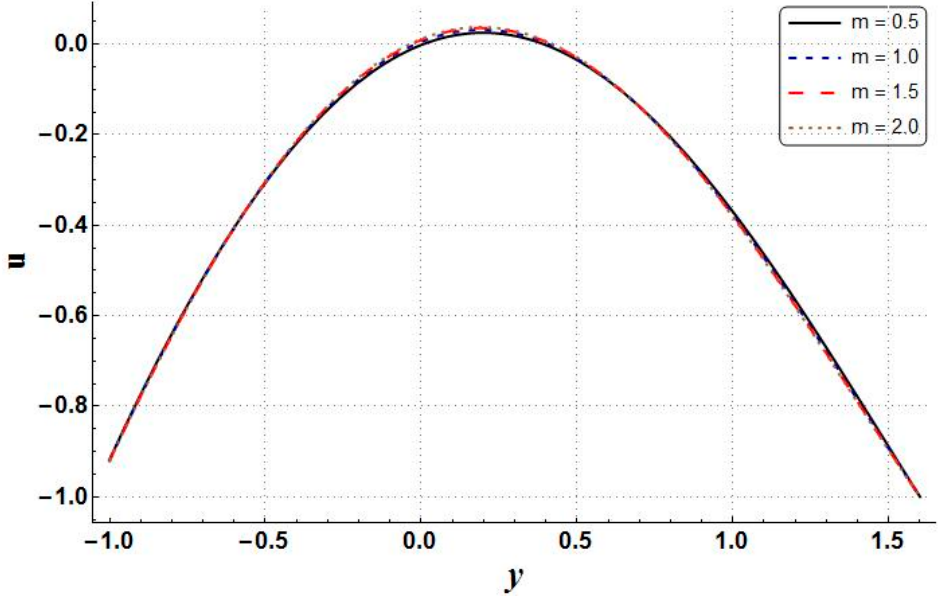
, x = 0, Gr = 2, α = π 4 M , where